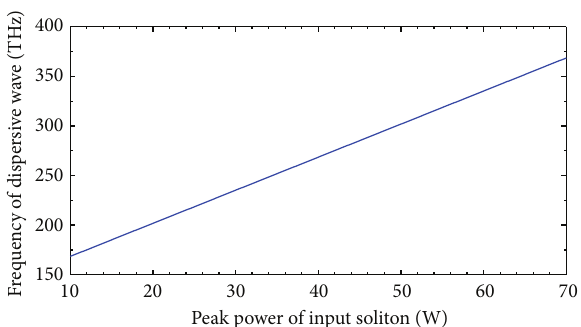
Figure 6: Frequency of dispersive wave emission as a function of inputting peak power of the soliton. The relative parameters are the same as used in Figure 4.